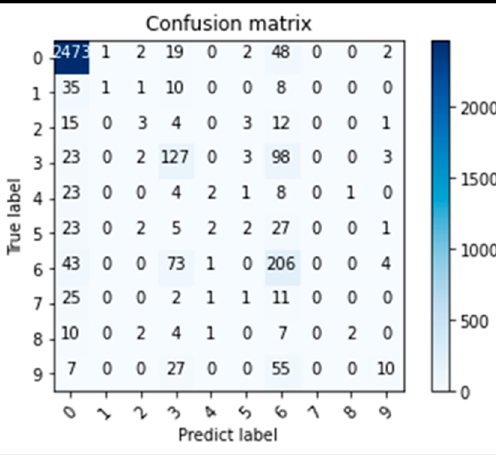
Figure 8. Confusion matrix of the raw data corresponding to the prediction data for the multi-class model.